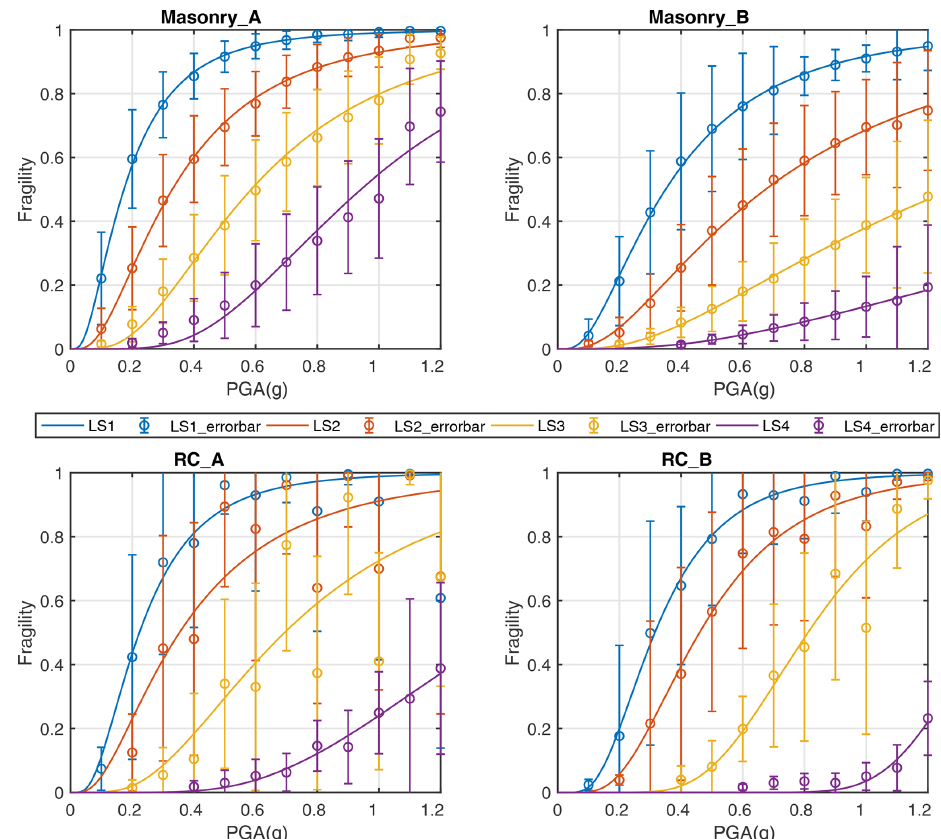
Figure 8. Fragility curve and error-bar analysis derived from analytical fragility datasets, which depict the relation between PGAs (unit: g) and exceedance probability of each damage limit state (LS1, LS2, LS3, LS4) for masonry and RC building types (note these median fragility curves are of varying robustness; see Sects. 4 and 5.3 for more details). The circle within each bar represents the median exceedance probability of each damage limit state; the length of each bar indicates the value of the corresponding standard deviation. Only intensity and PGA values with truncated exceedance probability ≥ 1% for each damage limit state of each building type are plotted, since higher damage states can appear only for higher intensities or PGA values (see Sect. 5.2 for more details). Detailed values of median fragility and standard deviation are given in Table